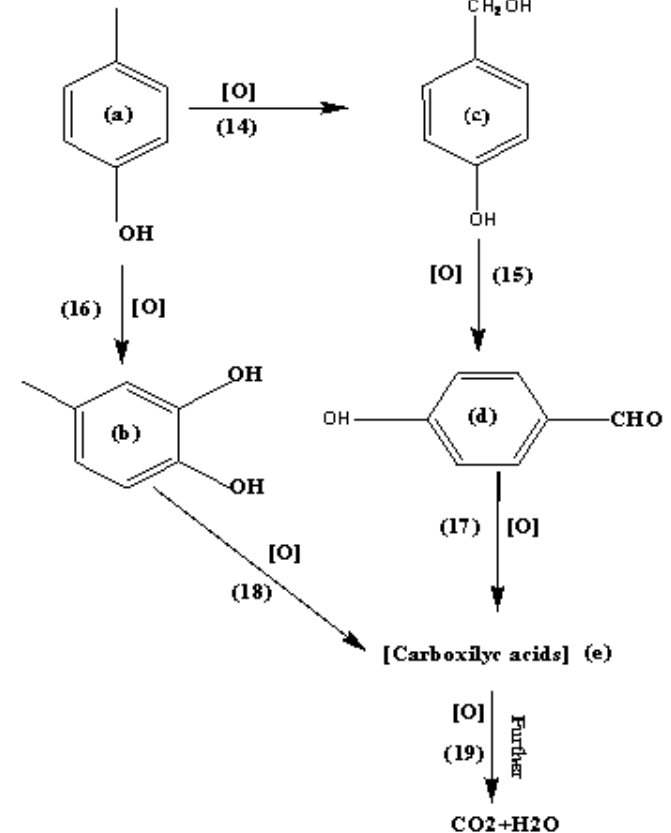
Figure 8. Reaction scheme proposed to account for the formation of degradation intermediates of p -cresol on illuminated aqueous ZnO: (a) p -cresol; (b) 4-methyl-1,2- benzodiol; (c) undetected; (d) 4-hydroxy-benzaldehyde; (e) carboxylic acids. [O] = HO•,